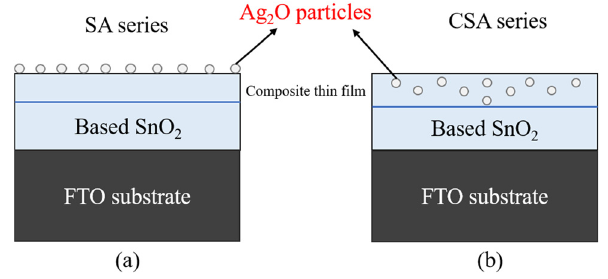
Figure 1: Schematics of thin - fi lm con fi guration: ( a ) SA and ( b ) CSA series